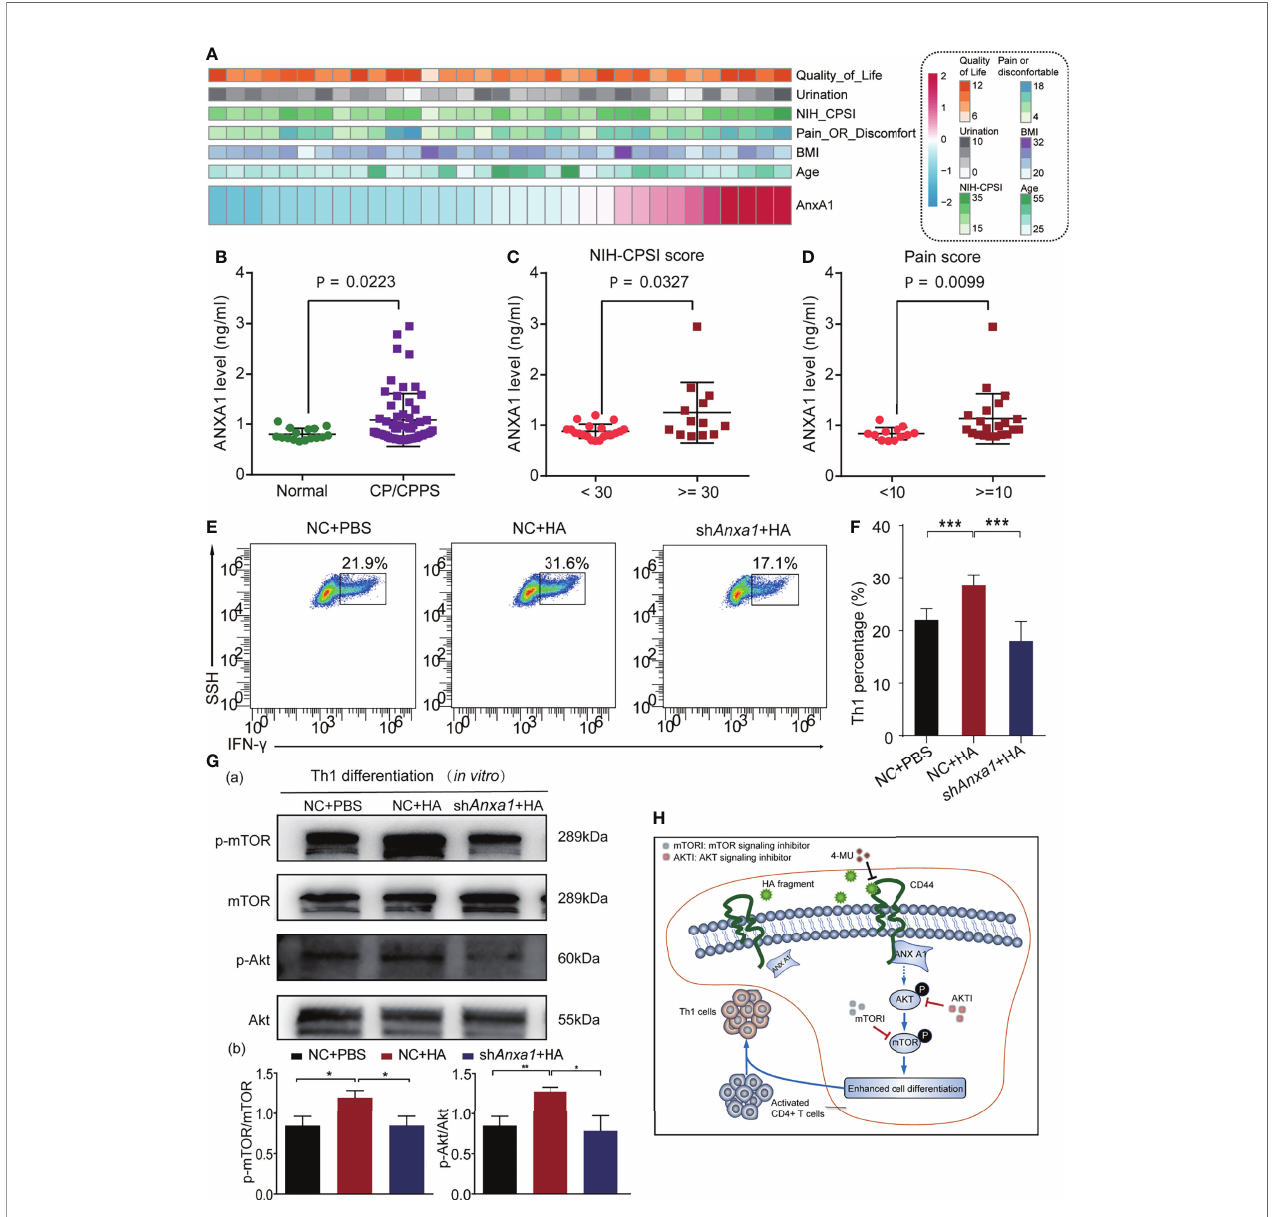
FIGURE 6 | HA/CD44 axis activated the Akt/mTOR pathway by promoting the expression of ANX A1, which was increased in CP/CPPS patients to promote Th1 cells differentiation. (A) Heatmap revealing the correlation between ANX A1 and several clinical features. (B) ANX A1 increased in CP/CPPS patients. (C) ANX A1 increased in severe NIH-CPSI scores. (D) ANX A1 increased in severe pain symptoms. (E) The differentiation percentage of Th1 cells in the in vitro differentiation experiment among NC + PBS, NC + HA, and sh Anxa1 + HA groups. (F) Corresponding data analysis according to data in (E, G) The expression levels of p-mTOR, mTOR, p-Akt, and Akt of Th1 cells in the in vitro differentiation experiment among NC + PBS, NC + HA, and sh Anxa1 + HA groups. (H) The possible mechanism of HA/CD44 promoting Th1 cells differentiation. ***p < 0.001, **p < 0.01, *p <